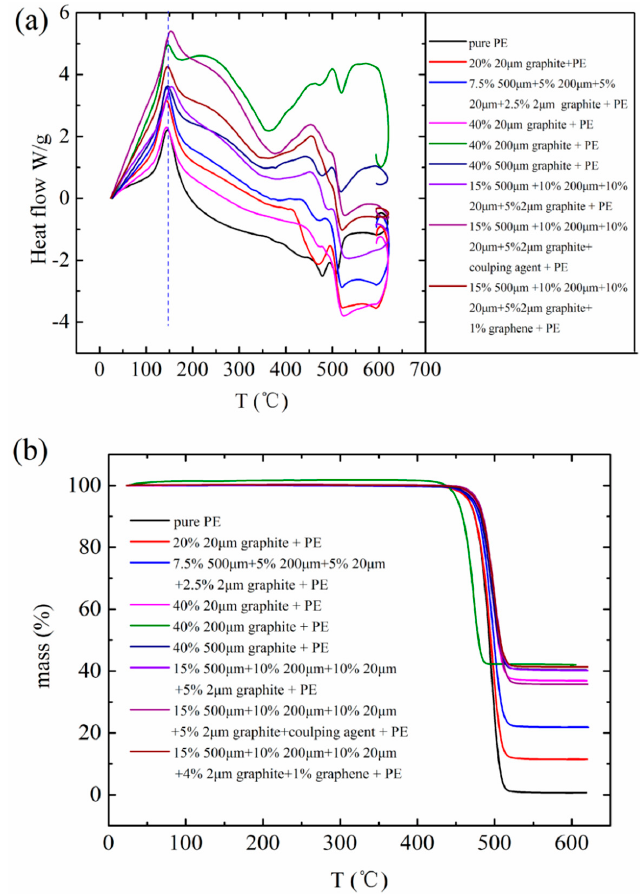
Figure 7. Thermal stability analysis about pure HDPE and relevant composites: ( a ) differential scanning calorimetry (DSC) scans of pure HDPE matrix and HDPE/FG composites and ( b ) thermogravimetric analysis (TGA) of pure HDPE matrix and HDPE/FG composites.